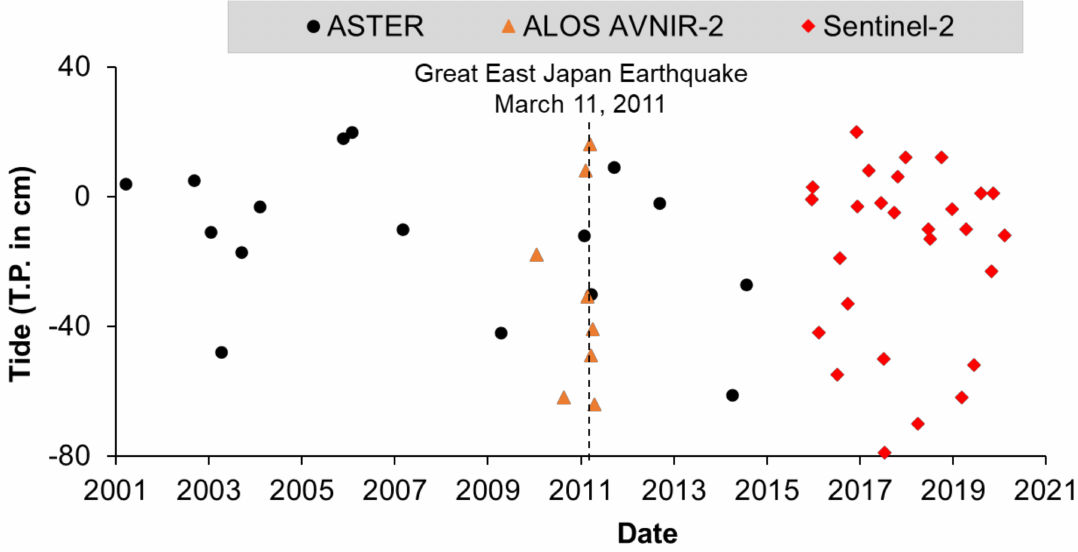
Figure 2. Acquisition date and tide level for each satellite observation for the northern portion (51 images). In this study, the amount of initial subsidence is defined as the average amount of subsidence for a set period (12 March 2011–31 March 2011) after the earthquake, as shown in Figure 3.